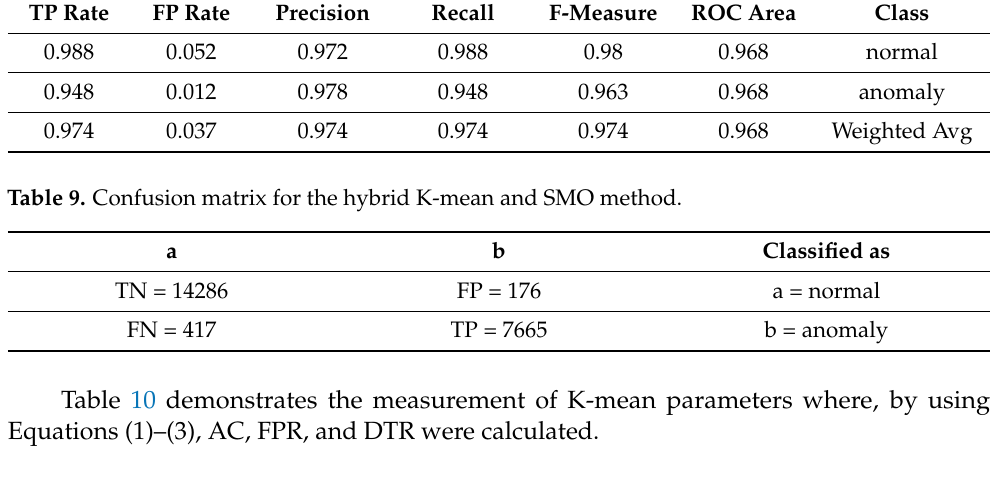
Table 10. Measurement parameters for the hybrid K-mean and SMO method.